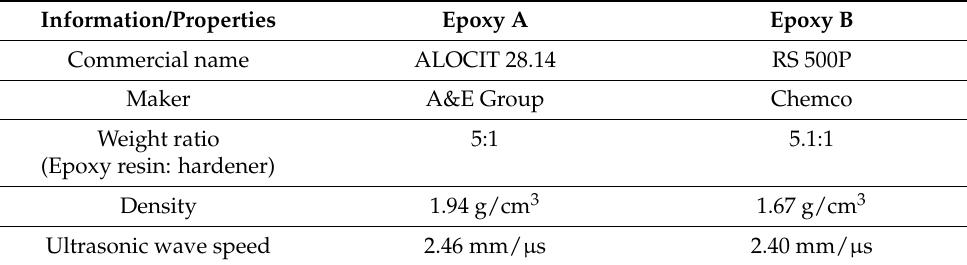
Table 1. Information/Material Properties of the coating materials.